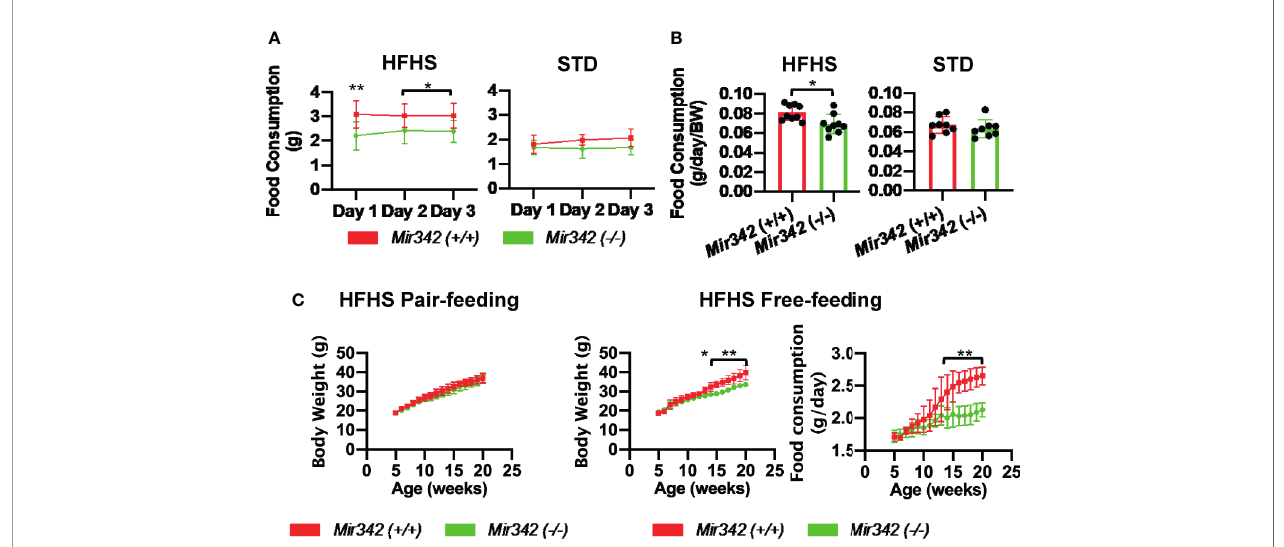
FIGURE 3 | Food intake of Mir342 (-/-) and Mir342 (+/+) mice fed with high fat-high sucrose (HFHS) or standard (STD) chow. (A) Daily food intake over 3 consecutive days of mice fed with HFHS (n=9) or STD chow (n=8) at 18 weeks of age. (B) Average food intake over 3 days per g body weight of mice fed with HFHS (n=9) or STD chow (n=8). (C) Pair-feeding studies in Mir342 (+/+) and Mir342 (-/-) mice fed with HFHS chow (n=5). Free-feeding mice (n=3 in each group) were used as controls to match the food intake. Data shown as mean ± SD and analyzed by independent t -test or two-way ANOVA with Bonferroni tests (*p < 0.05; **p <